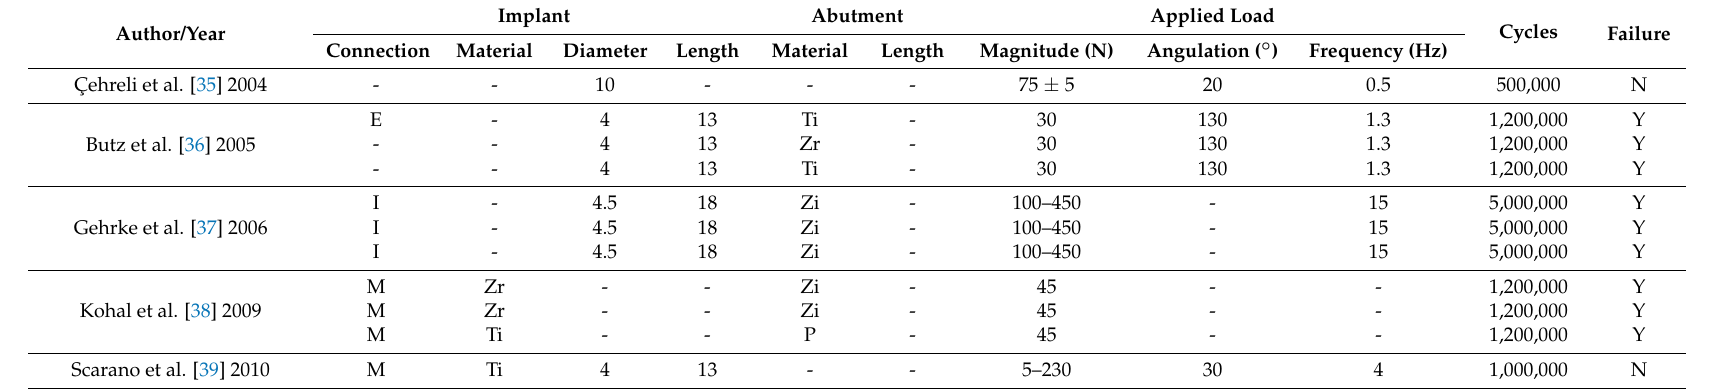
Table 3. Variables analyzed from the answer to question